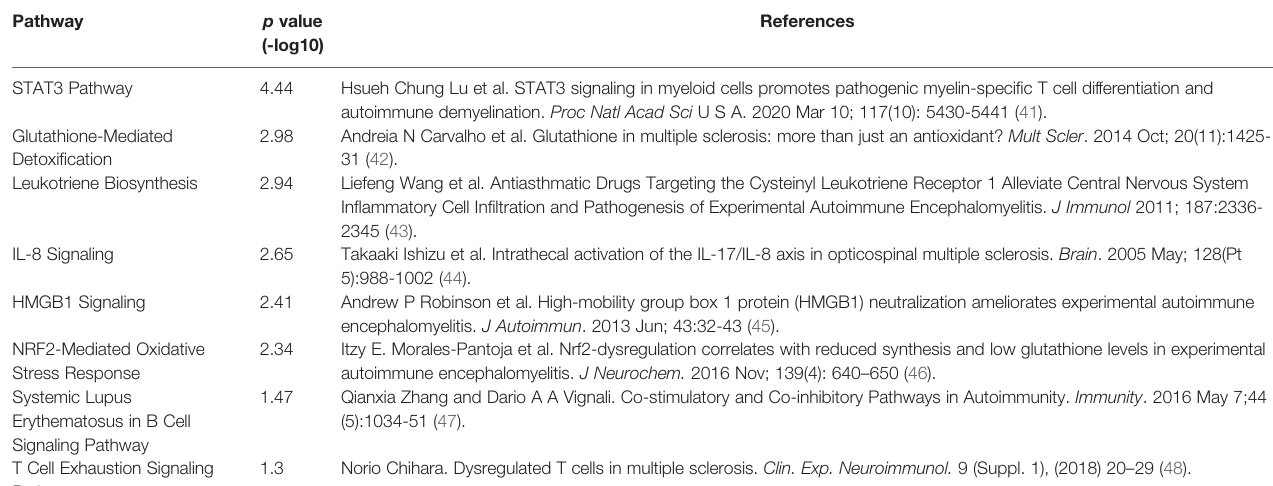
TABLE 1 | Nox2 dependent pathways in microglia with an association with multiple sclerosis or experimental autoimmune encephalomyelitis (EAE). Pathway p value